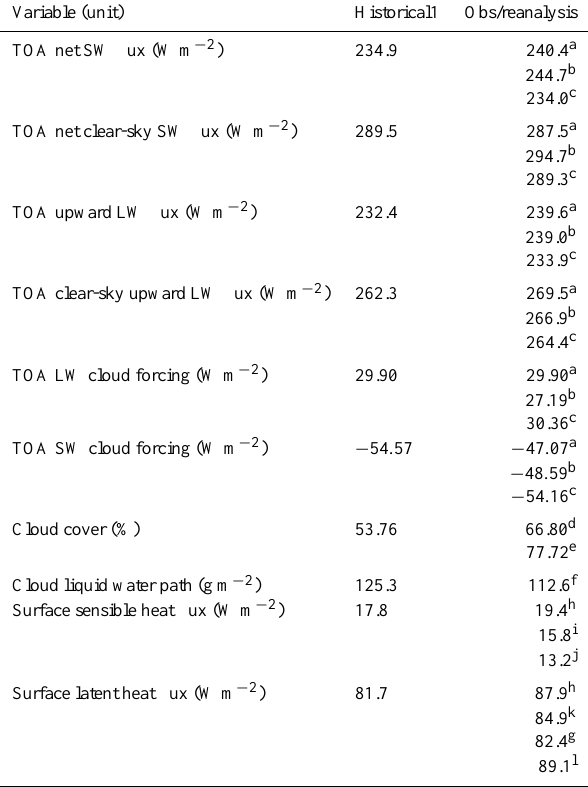
Table 1. Global and annual averages of model calculated (for the period 1976–2005 of Historical1) vs. observationally based or rean- alyzed atmospheric